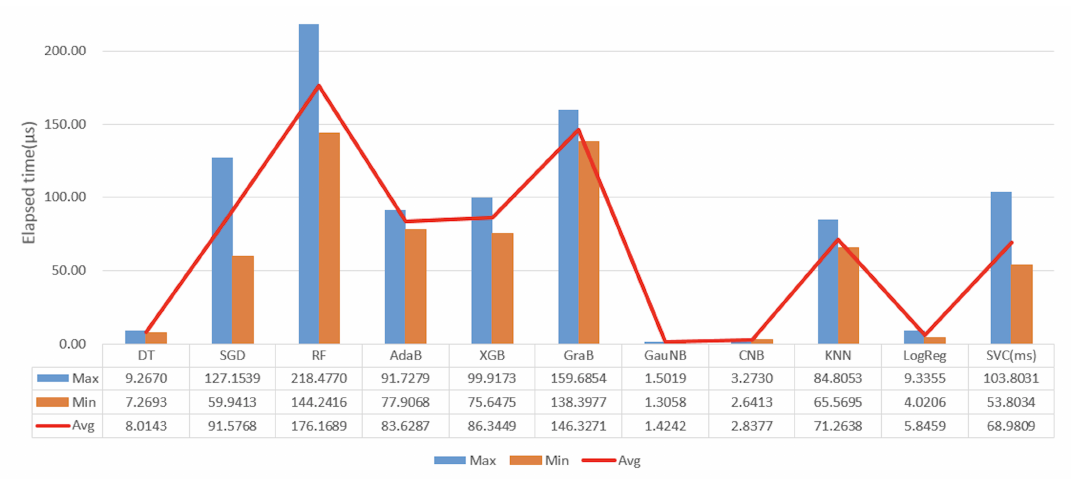
Figure 13. Comparison chart for the elapsed time of per event in a µs.